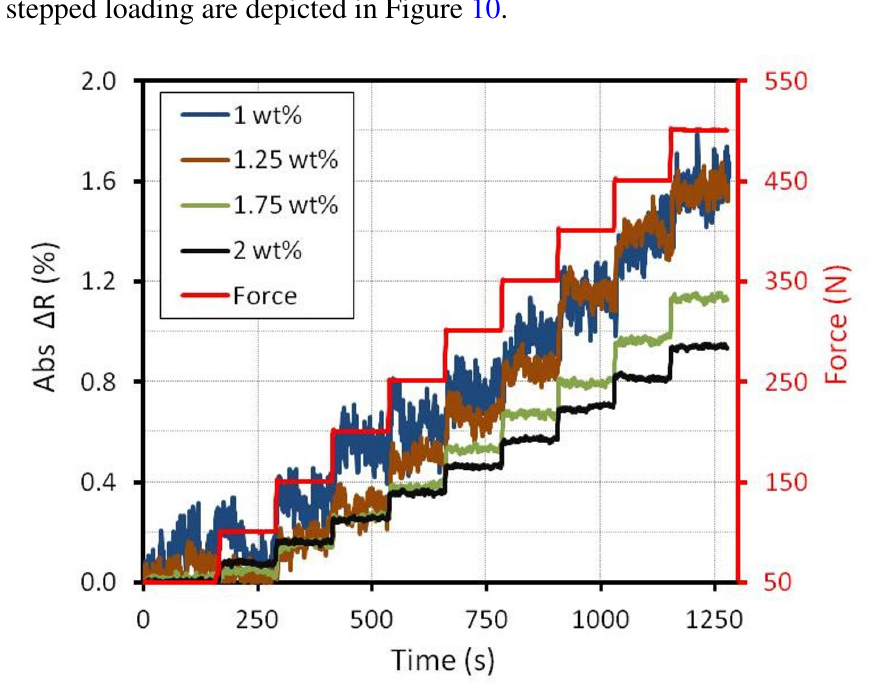
Figure 10. Stability of the signals by stepped loading in a half bridge